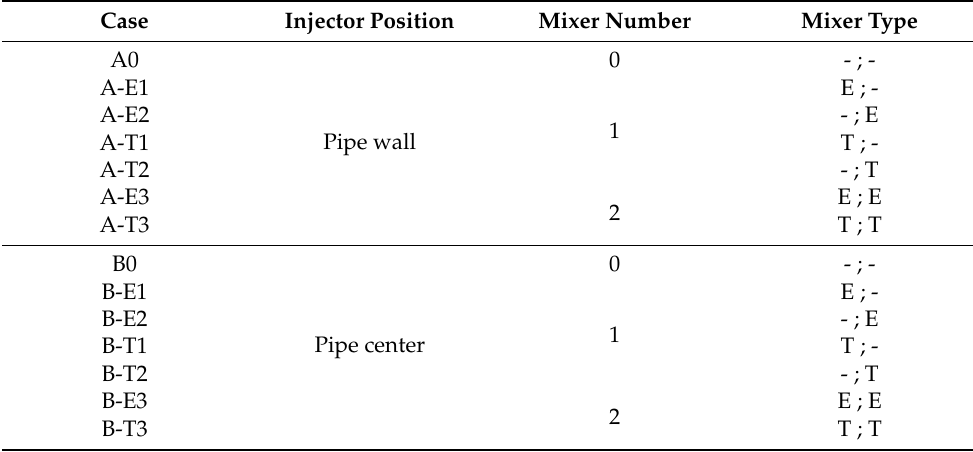
Table 1. Simulation cases.